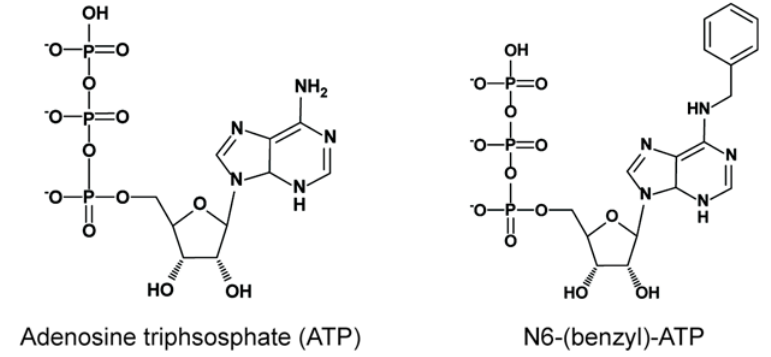
Figure 2. Chemical structures of ATP and the derivative